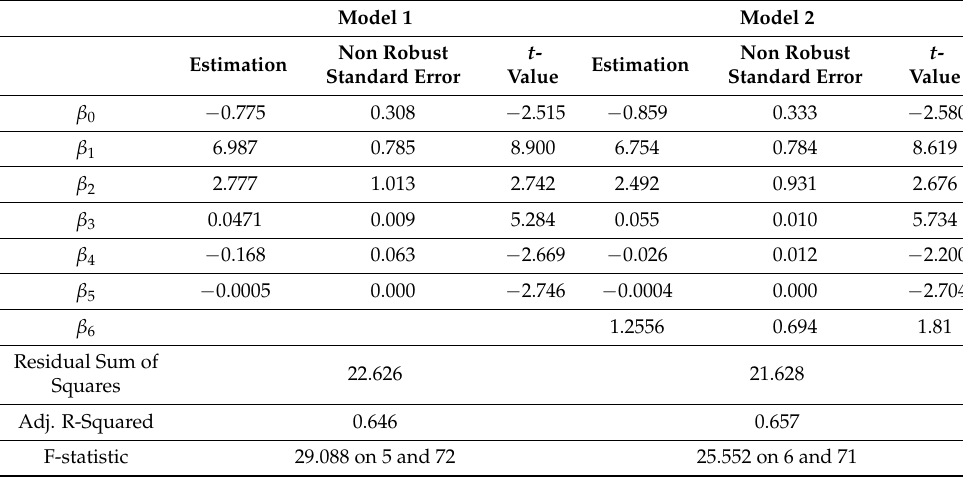
Table 2. Model estimation